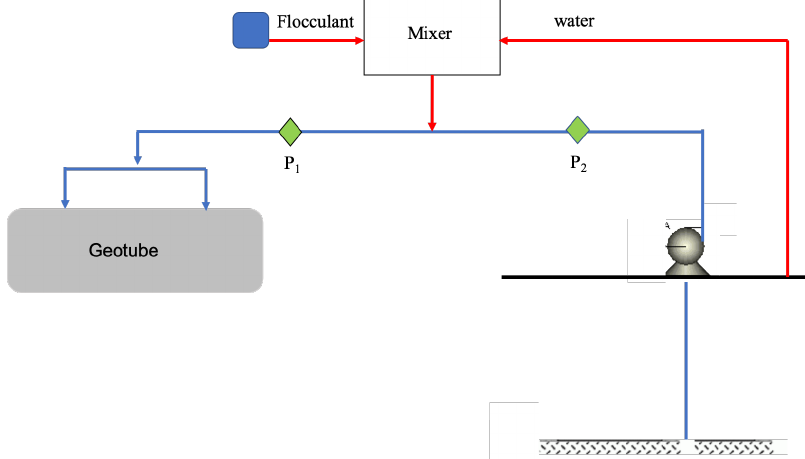
is the collection point of 1 is the pick-up point for material coming directly 2